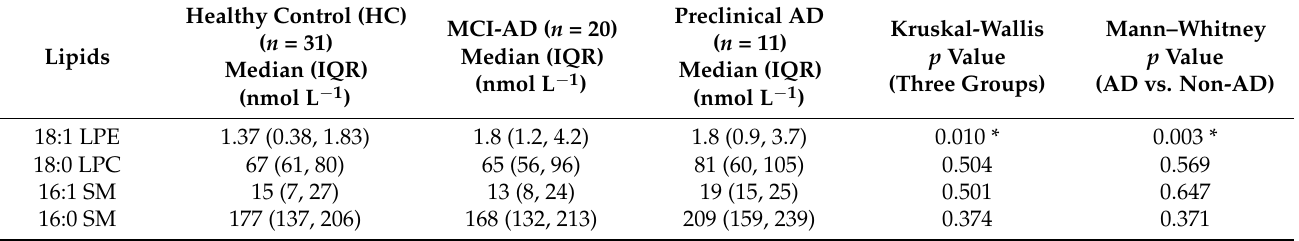
Table 5. Lipid concentrations in plasma from participant groups (healthy, MCI-AD, and preclinical